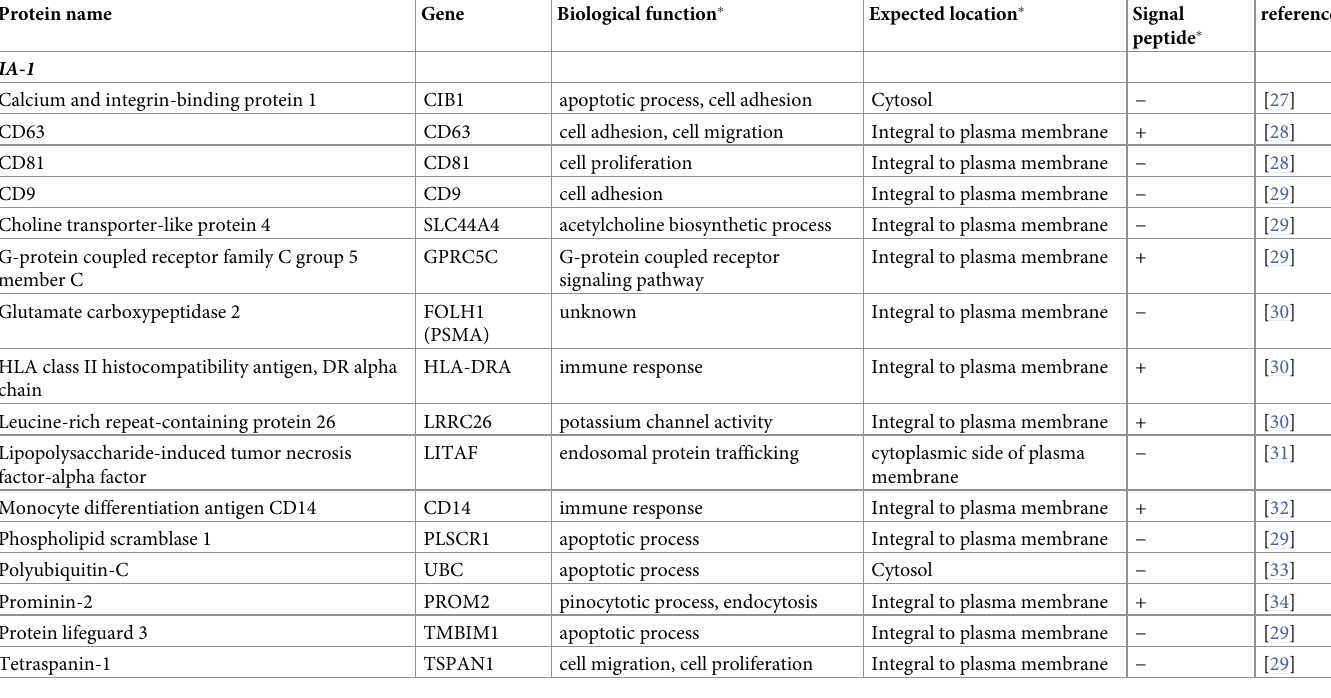
Table 1. List for of proteins classified into